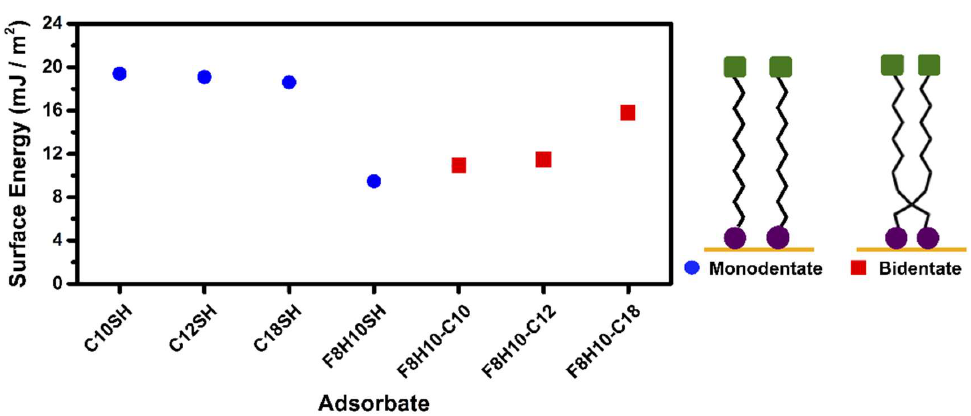
Figure 8. Surface energy calculated using the Owens-Wendt approach for the monodentate thiols and the F8H10-Cm dithiols.